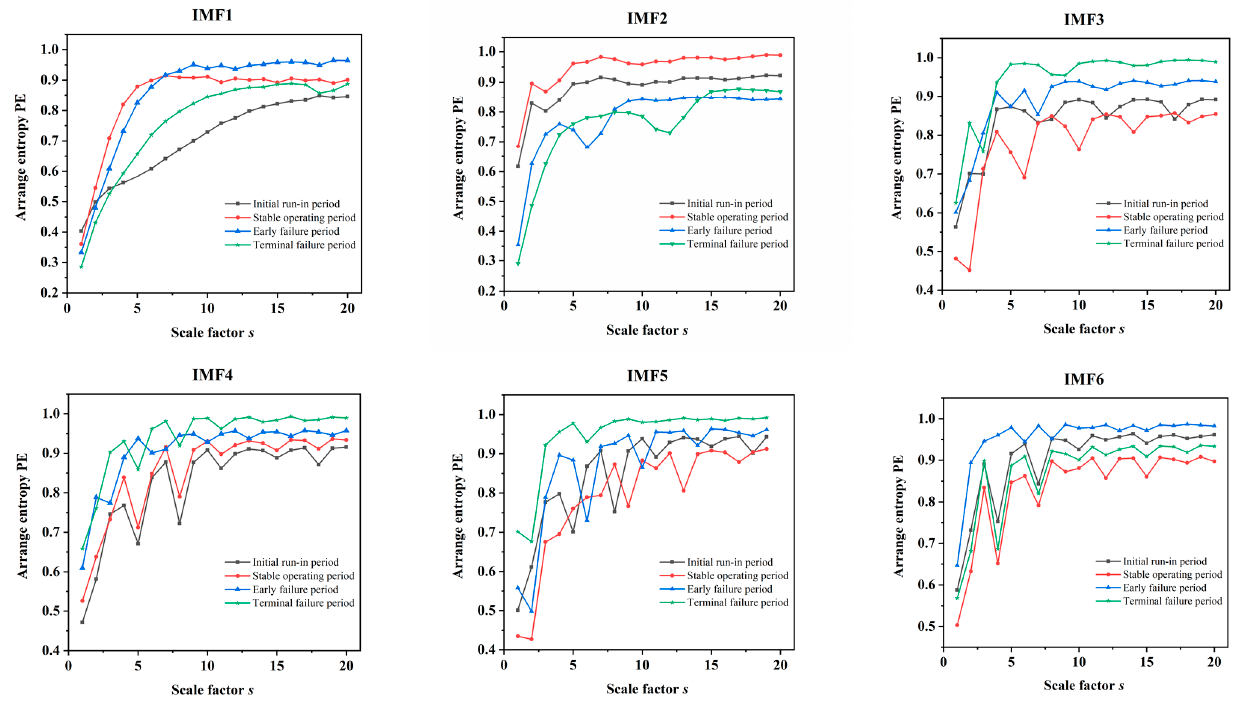
Figure 9. MPE values of the internal gear pump in the four operating periods under different modes